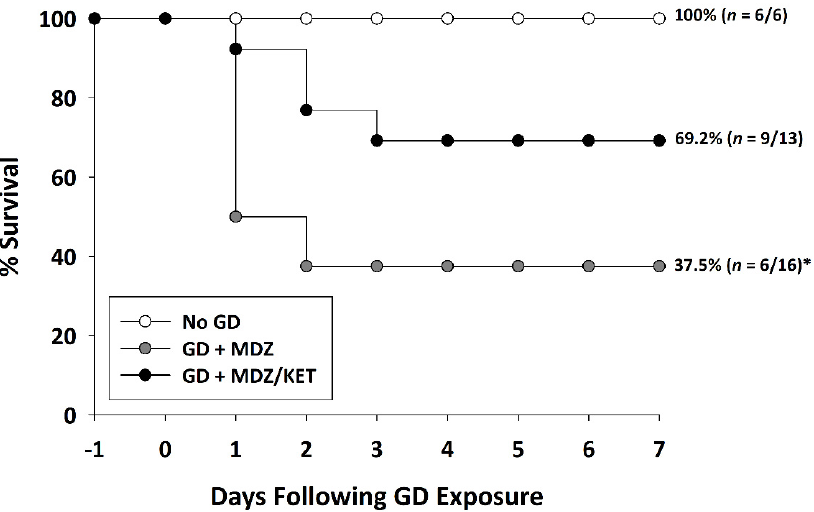
Figure 4. Effect of delayed midazolam (MDZ) treatment combined with ketamine (KET) on survival following GD-induced status epilepticus in KIKO mice. Mice exposed to GD and treated with midazolam monotherapy (GD + MDZ) at 15 min after seizure onset had a significantly lower percentage of survival compared to that of the saline control (No GD) group. In contrast, soman-exposed mice that were treated with a combination of midazolam and ketamine (GD + MDZ/KET) had a higher percentage of survival that was not significantly different from the percentage of survival of the No GD group. * p < 0.05, compared to No GD group.